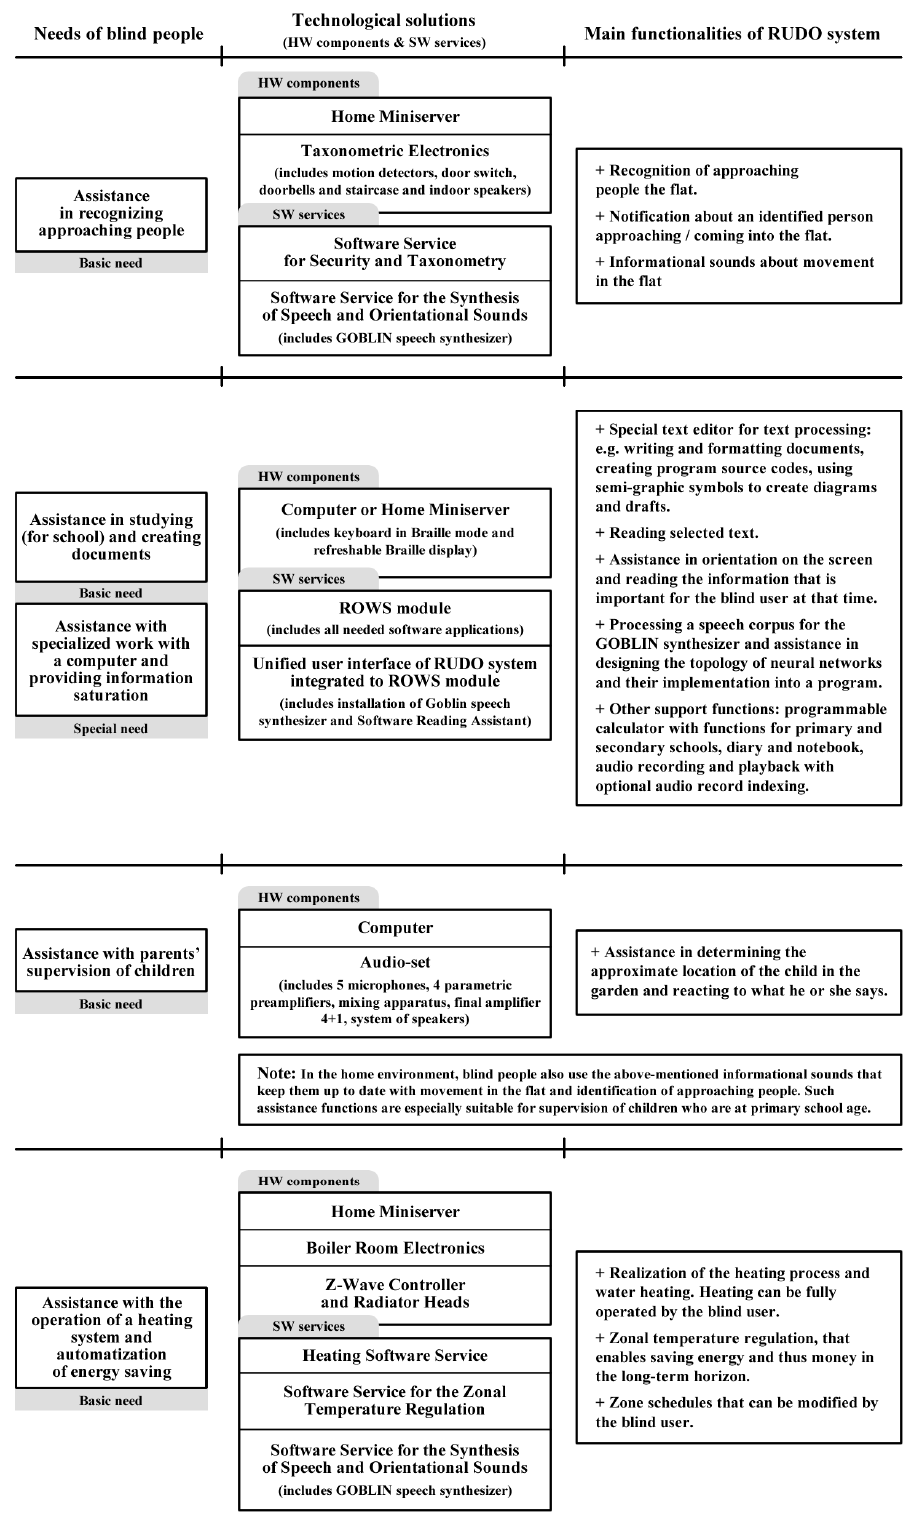
Figure A1. Scheme linking identified needs of blind people, technological solutions and main functionalities associated with the RUDO system.